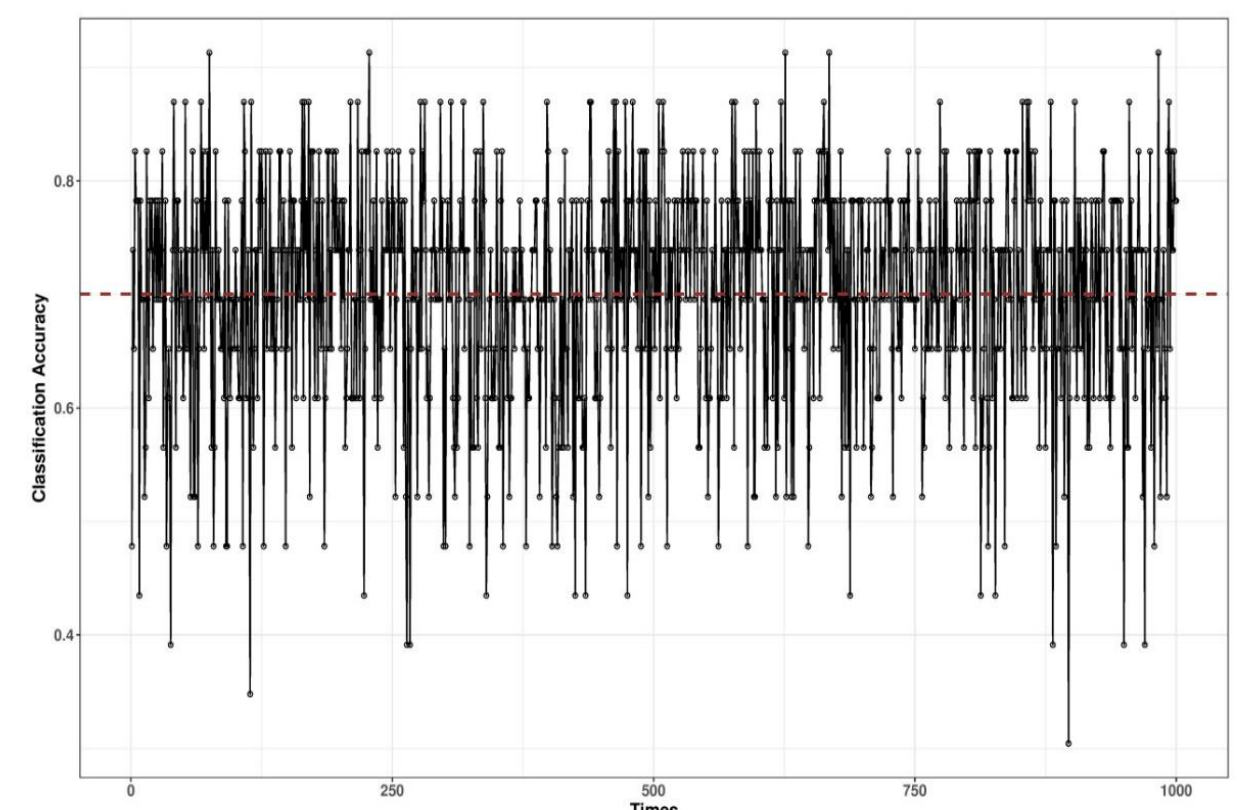
Figure 7. Validation for the BN-based surgical phase classification.